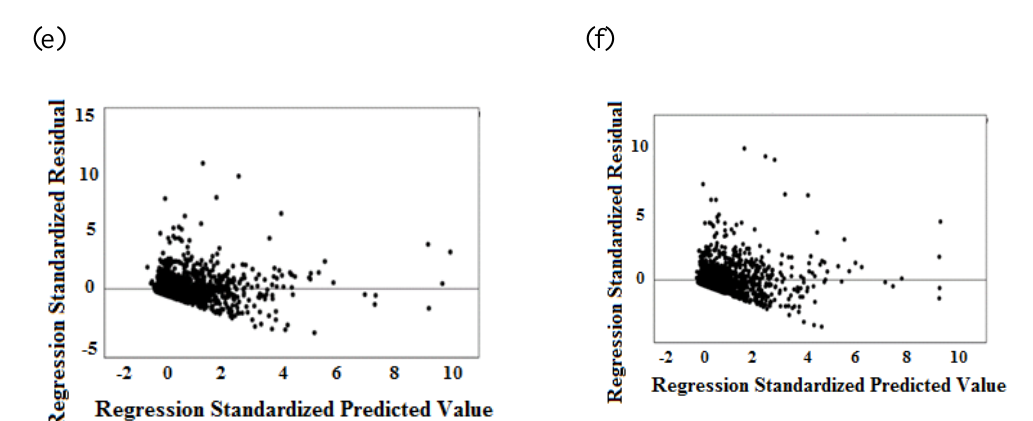
Figure 2. ( a ) Standardized residual analysis of PM 10,t + 1 , ( b ) standardized residual analysis of PM 10,t + 2 , ( c ) standardized residual analysis of PM 10,t + 3 , ( d ) testing assumption of variance and uncorrelated with mean equal to zero for model PM 10,t + 1 , ( e ) testing assumption of variance and uncorrelated with mean equal to zero for model PM 10,t + 2 , ( f ) testing assumption of variance and uncorrelated with mean equal to zero for model PM 10,t + 3 .